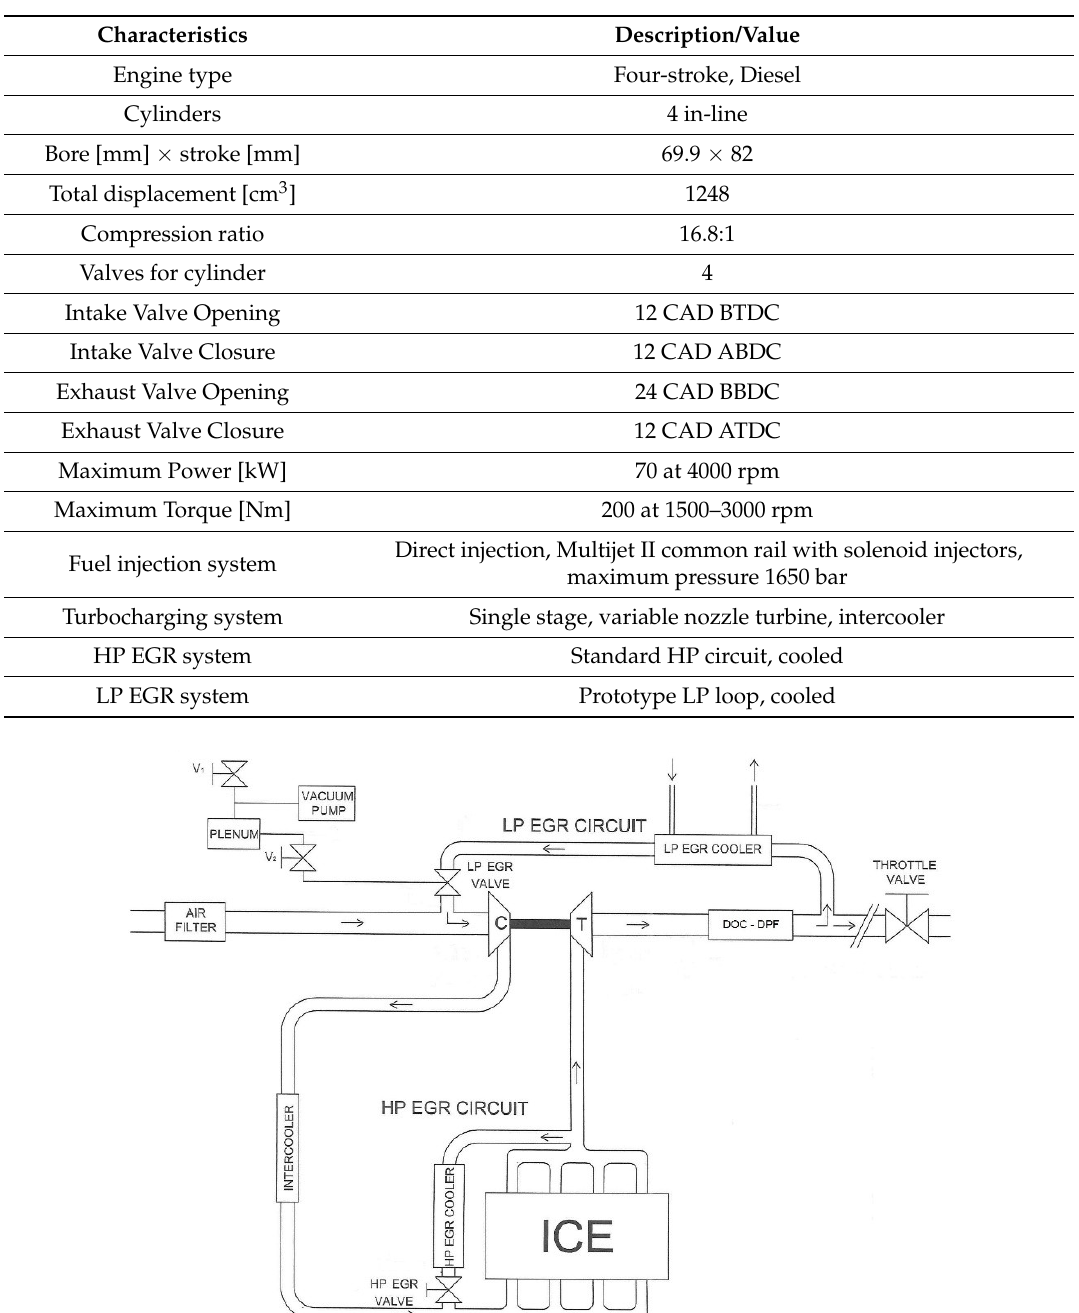
Table 1. Characteristics of the tested engine.